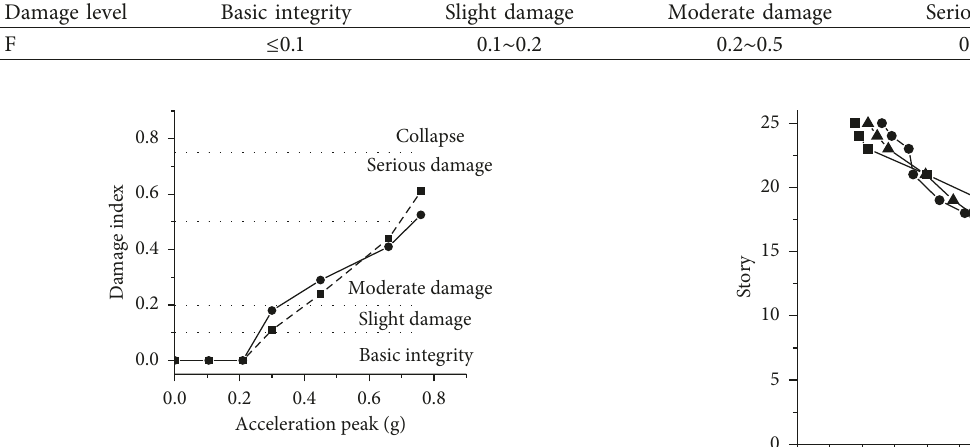
Figure 16: Overall damage.